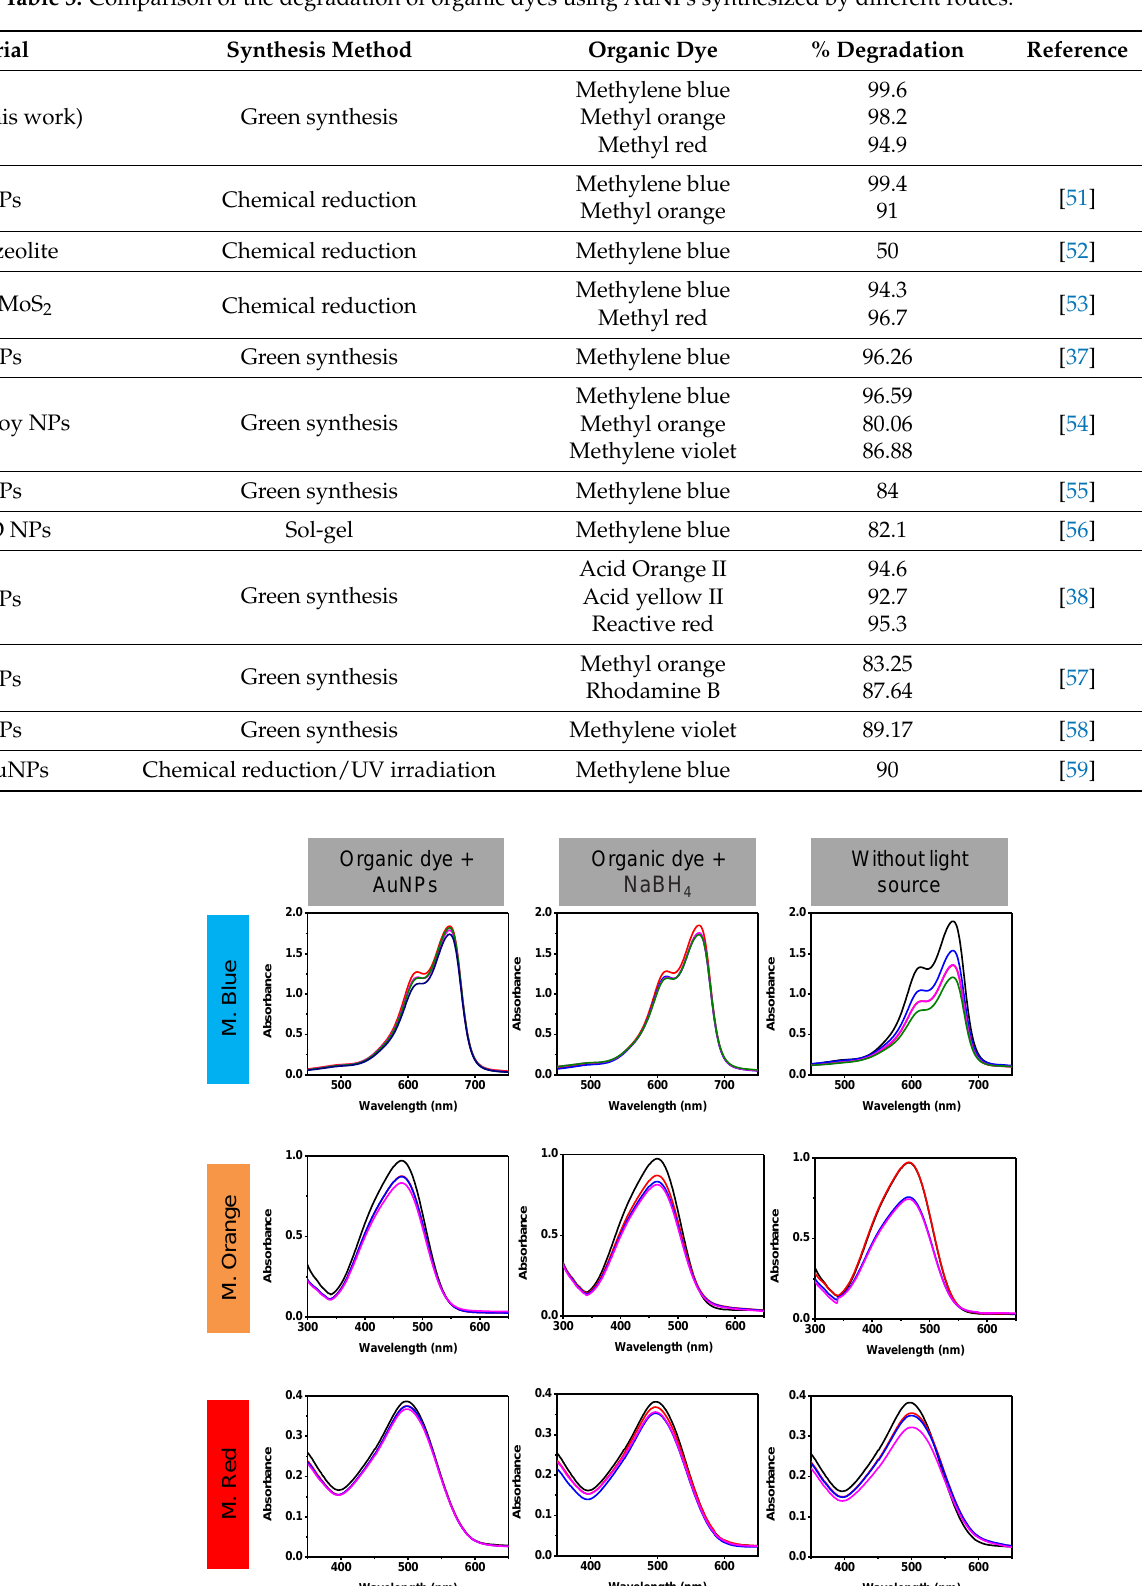
Table 3. Comparison of the degradation of organic dyes using AuNPs synthesized by different routes.